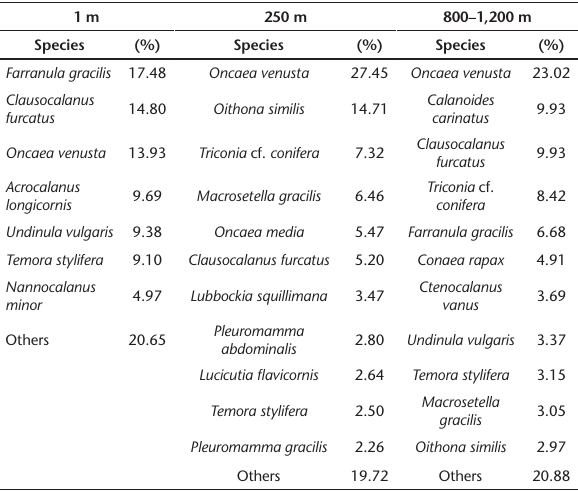
Table 4. Copepod species and their contribution (%) to the sim- ilarity of assemblages obtained during the rainy season through the SIMPER analysis.